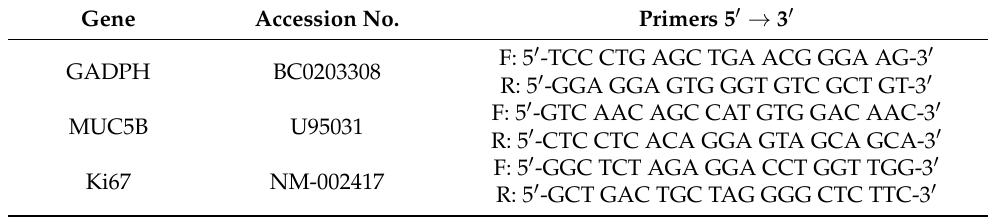
Table 1. Primer sequences used in real-time PCR for quantitative gene expression analysis of respiratory